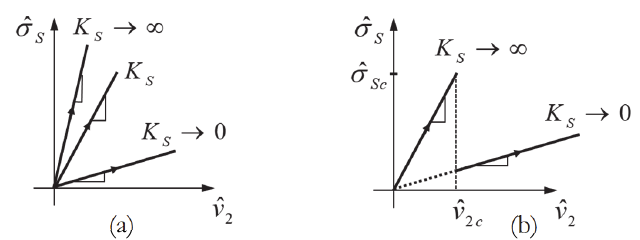
Figure 2: (a) Exemplary interfacial traction laws used to describe a n -layered beam with continuous fully bonded, imperfectly bonded and fully detached interfaces, as shown in Fig. 1b (after [14]); (b) interfacial traction law used to analyze perfectly brittle fracture in the n -layered beam in Fig. 1c; the crack tip is defined at the coordinate where the sliding displacement becomes critical, .